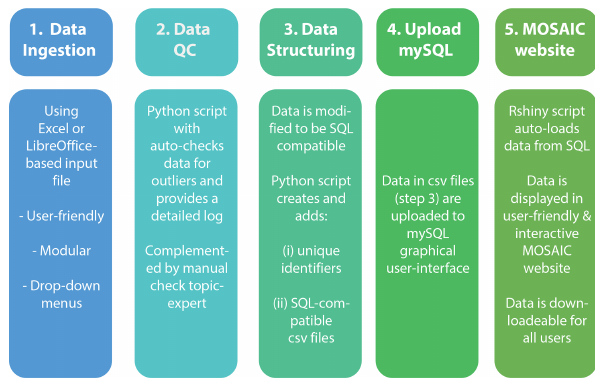
Figure 1. Overview of the MOSAIC pipeline. Data ingestion